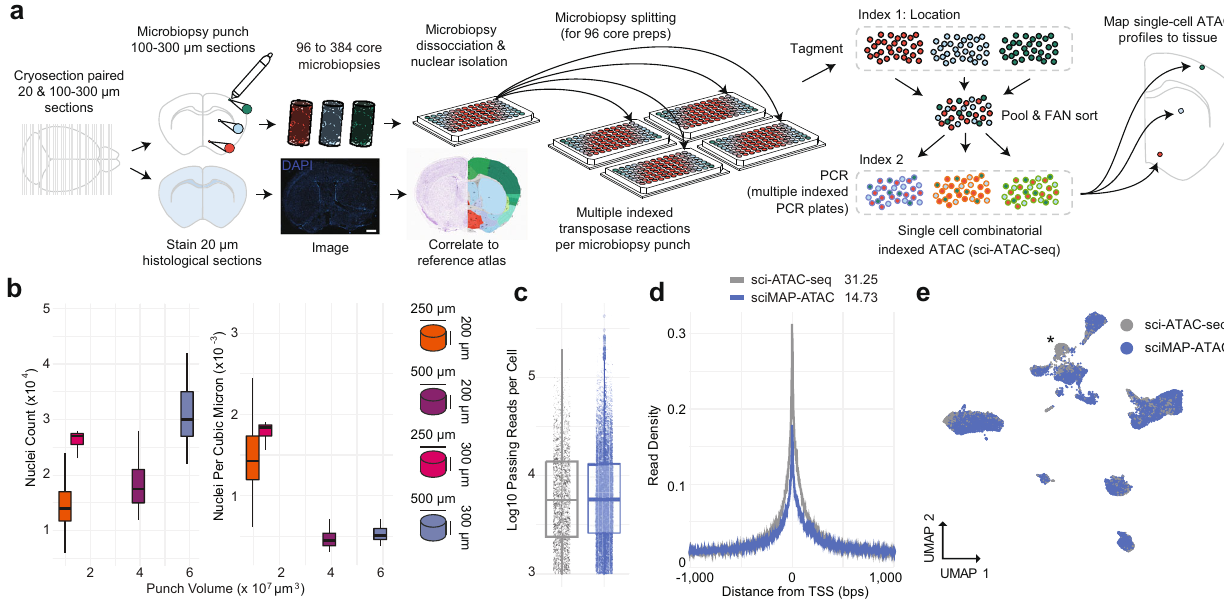
Fig. 1 sciMAP-ATAC schematic and performance. a sciMAP-ATAC work fl ow. Cryosectioning of alternating 20 µ m (histological) and 100 – 300 µ m (sciMAP-ATAC) slices are obtained. Thin (20 µ m) slices are stained and imaged for use in spatial registration (scale bar, 1 mm) to a reference atlas (Allen Mouse Brain Atlas: http://atlas.brain-map.org/atlas?atlas = 1&plate = 100960312, ref. 25 ). Thick (100 – 300 µ m) slices are carried through high-density microbiopsy punching (100 – 500 µ m diameter) in the cryostat chamber. Punches are placed directly into wells of a microwell plate for nuclei isolation, and washed prior to splitting into multiple wells for indexed transposition and the sci-ATAC-seq work fl ow. b Four punch volumes were assessed for nuclei yield using either a 250 or 500 μ m diameter punch on a 200 or 300 μ m thick section. Total nuclei isolated for each punch is shown on the left, and normalized for tissue voxel volume on the right, representing the ef fi ciency of extraction from each punch, for punches with dimensions 250 ×200 μ m ( n = 48),